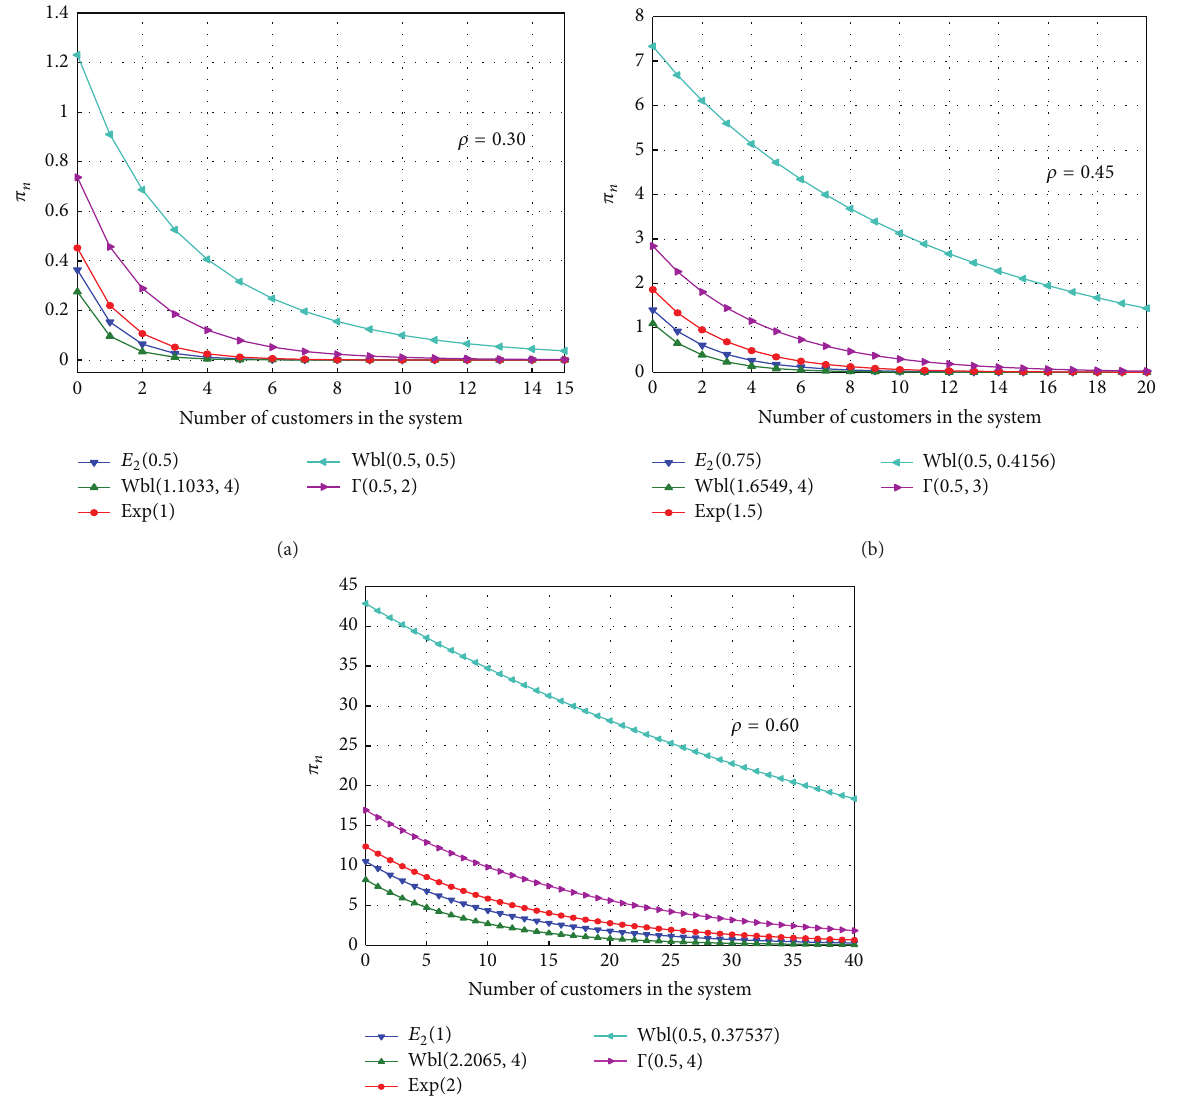
Figure 3: Comparison of the stationary distributions of the number of customers in the systems for the three considered